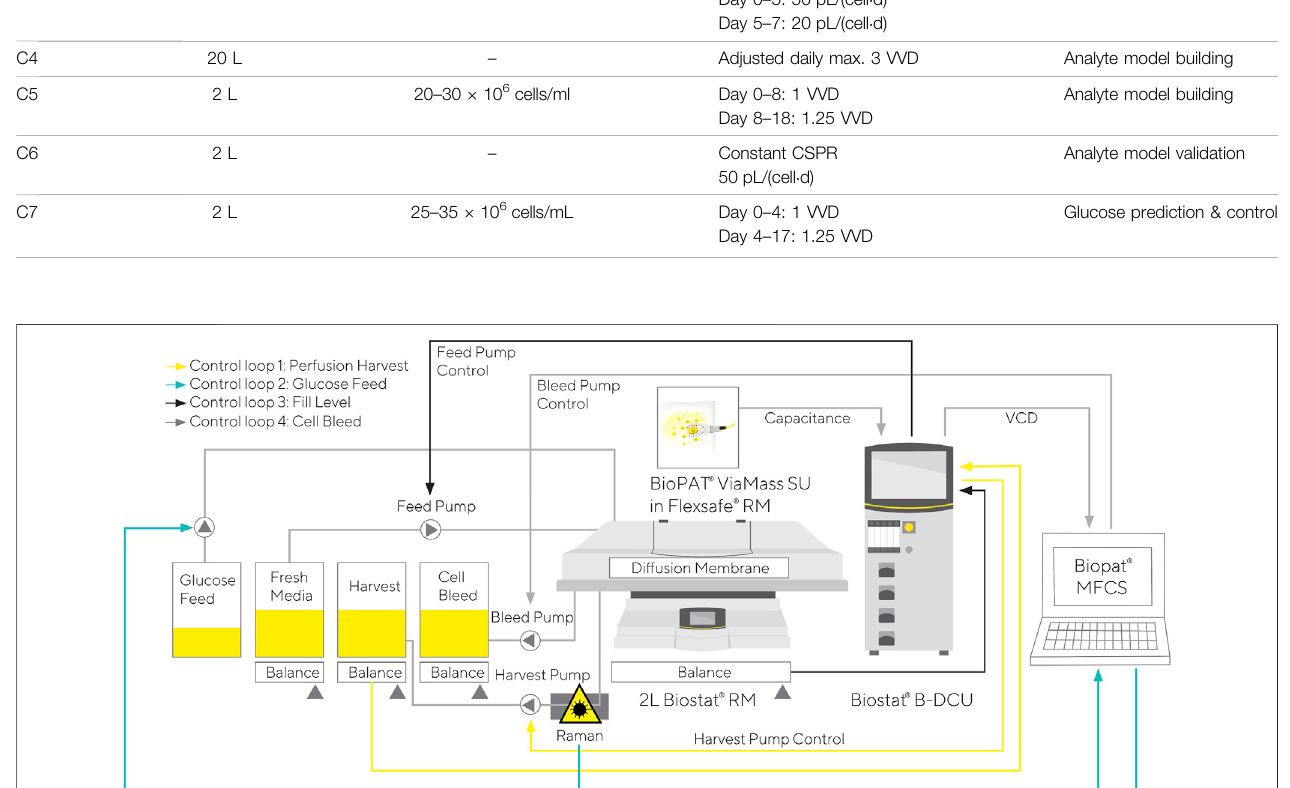
FIGURE 1 | Control mechanism for RM perfusion cultivation with glucose control based in-line Raman